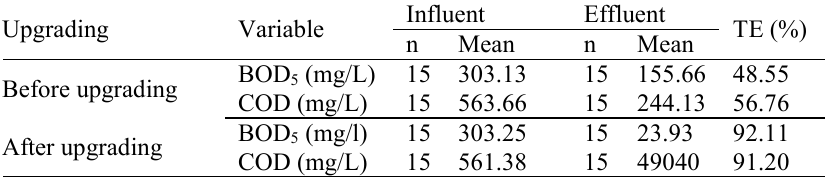
Table 3. Treatment efficiencies of TMWTP (before and after